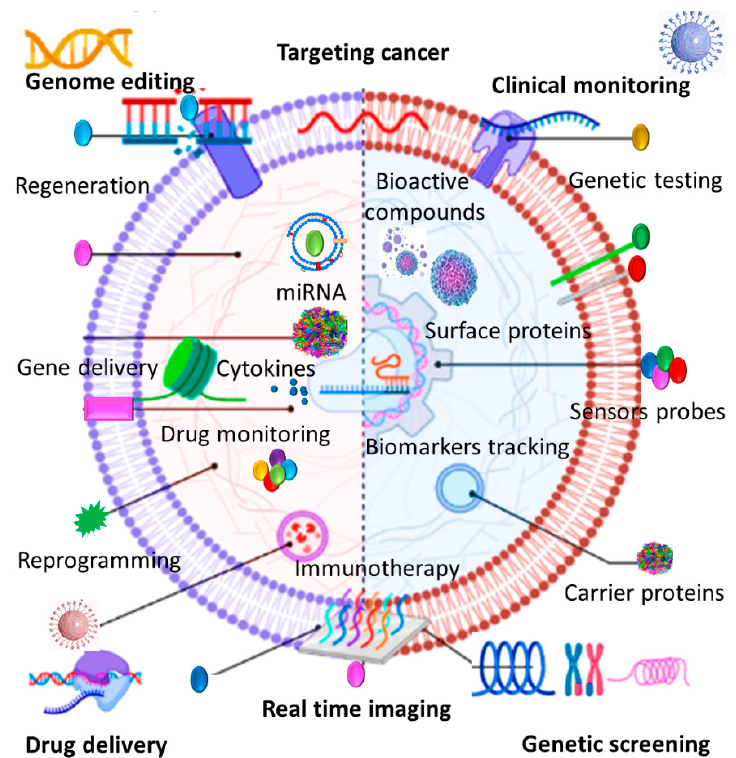
Figure 2. EVs can be involved in cancer therapy as diagnostic markers, therapeutics, and drug delivery tools.